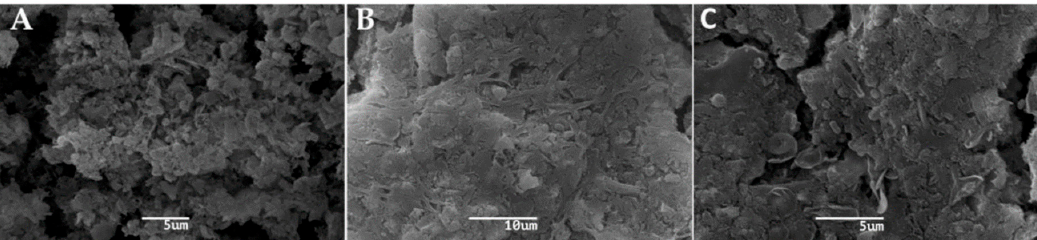
Figure 1. Scanning Electron Microscopy (SEM) of the reverse osmosis (RO) membrane of the north-central area dialysis centre showing the presence of biofilm. ( A ): initial segment of RO membrane. ( B ): middle segment of RO membrane. ( C ): final segment of RO membrane. The scale bar is 5 µ m, 10 µ m and 5 µ m, respectively.